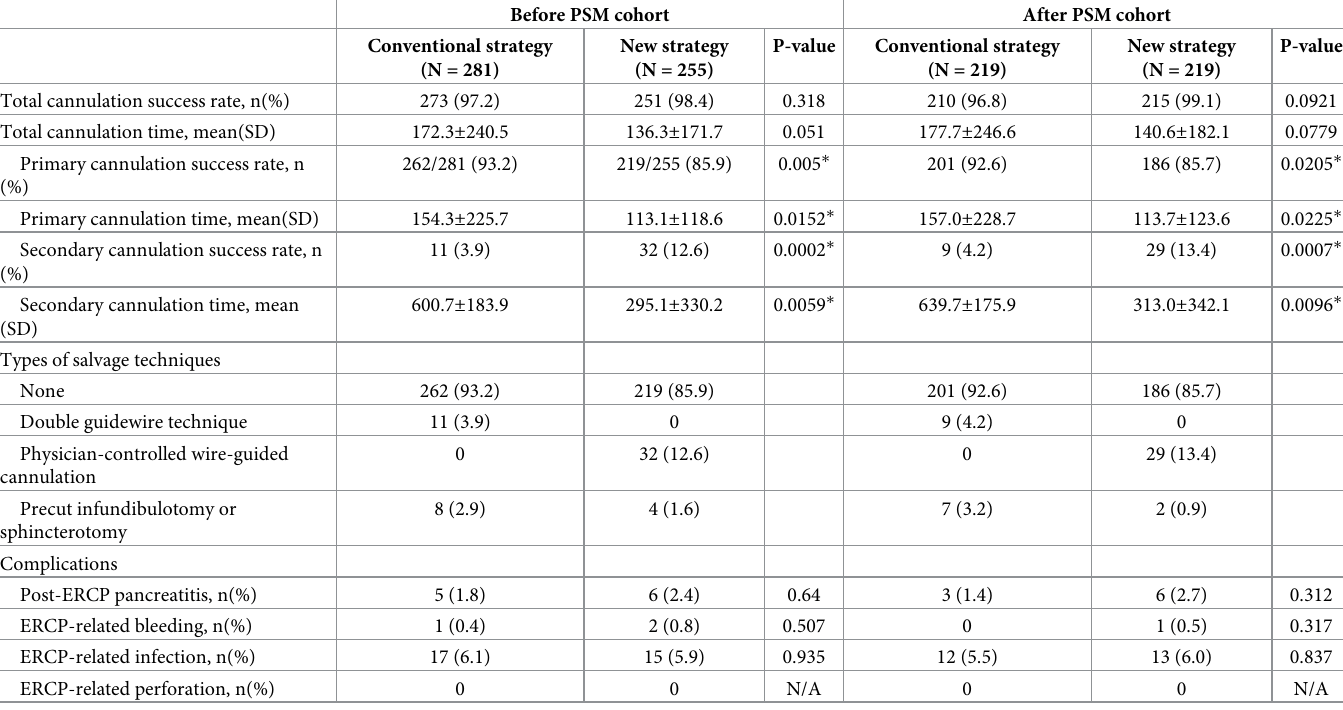
the groups (97.2% vs. 98.4%; p = 0.318). The total cannulation time was similar in both groups (172.3 s vs. 136.3 s; p = 0.051). The initial cannulation method was more successful in the con- ventional strategy group than that in the new strategy group (93.2% vs. 85.9%, p = 0.005), and there was statistically significant difference in the initial cannulation time (p = 0.0152). Rescue management failed to achieve successful cannulation in eight patients (2.9%) in the conven- tional strategy group and in four patients (1.6%) in the new strategy group. The incidence of Table 2. Comparison of clinical outcomes between conventional and new strategy groups in the before PSM and after PSM